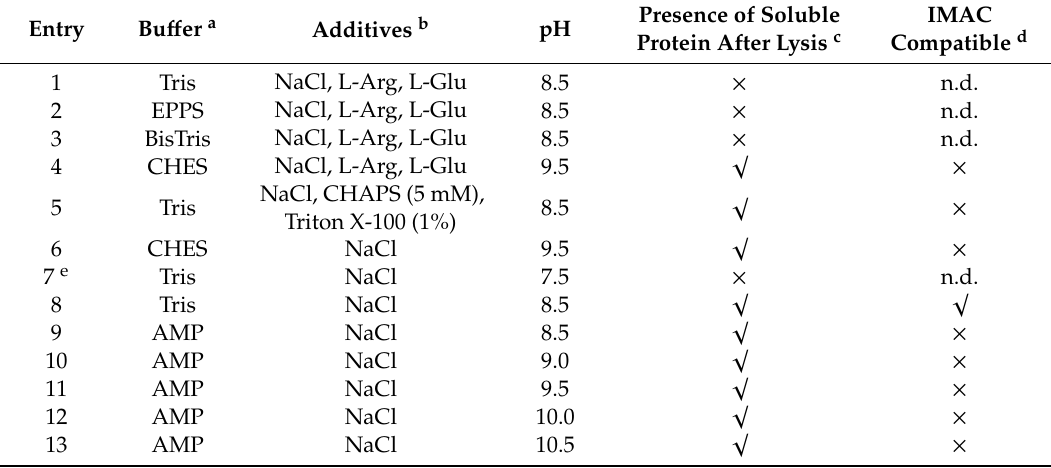
Table 1. Bu ff er compositions investigated during cell lysis and IMAC purification of His 6 -Sil α